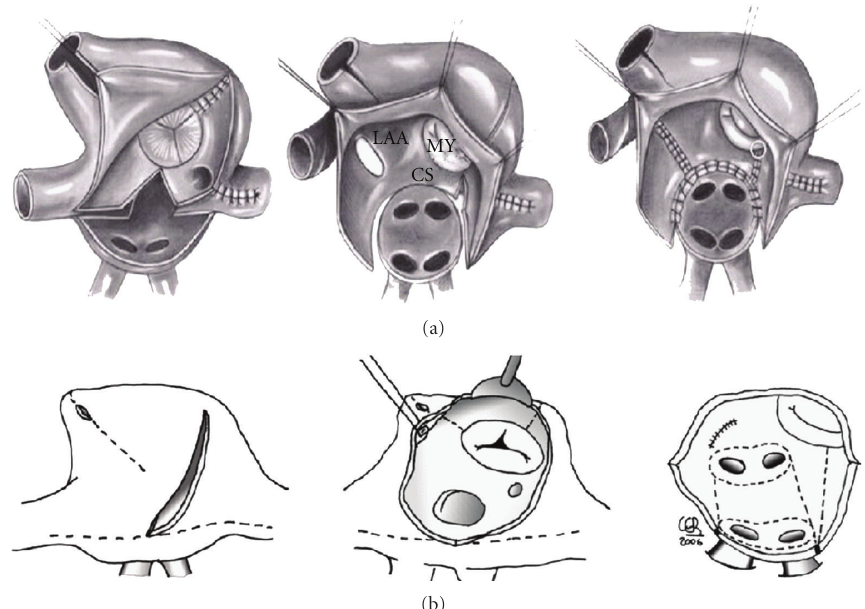
Figure 1: (a) Cox-Maze III: Lesion pattern described by James Cox in 1991 with cut and sew technique. (b) Cox-Maze IV: Similar lesion pattern, with alternative energy lesion in dotted lines and trying to minimize incisions in both atria. Only the left appendage is excised.